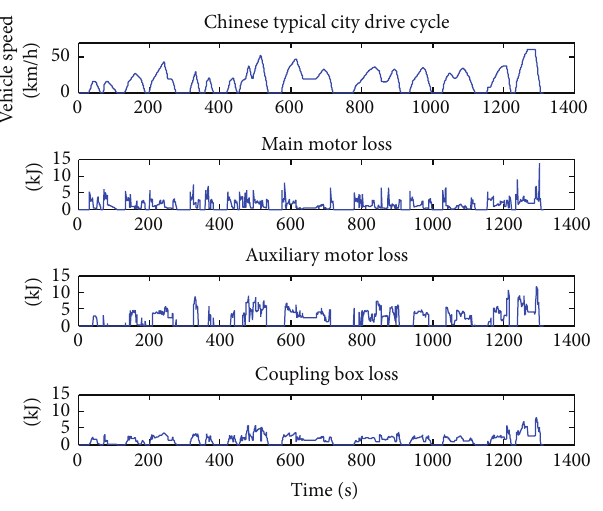
Figure 5: Energy-loss distribution. Figure 6: The trend of the energy loss and number of shifts with the change of 𝛼 .